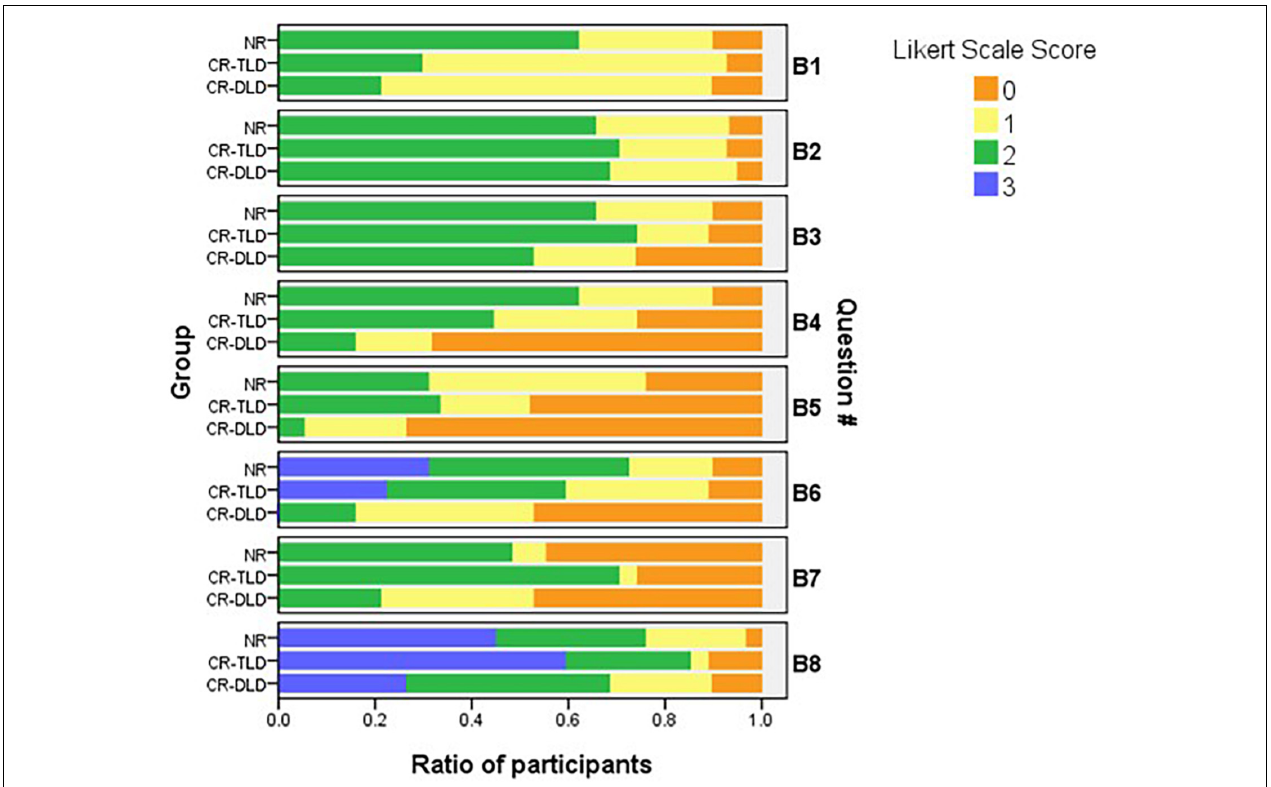
FIGURE 2 | A comparison of the responses to Section B questions within each group.